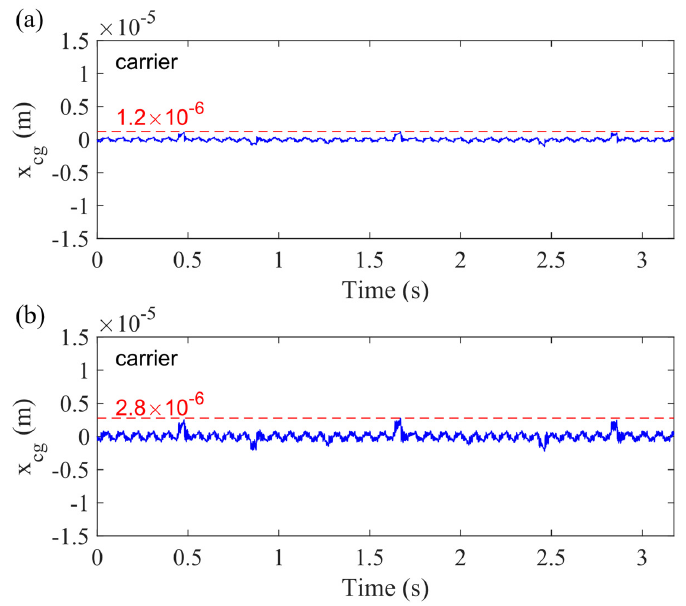
Figure 11. Vibration response of carrier for the 50% sun gear crack level for ( a ) Case 1 and ( b ) Case 2, both in x g -direction.